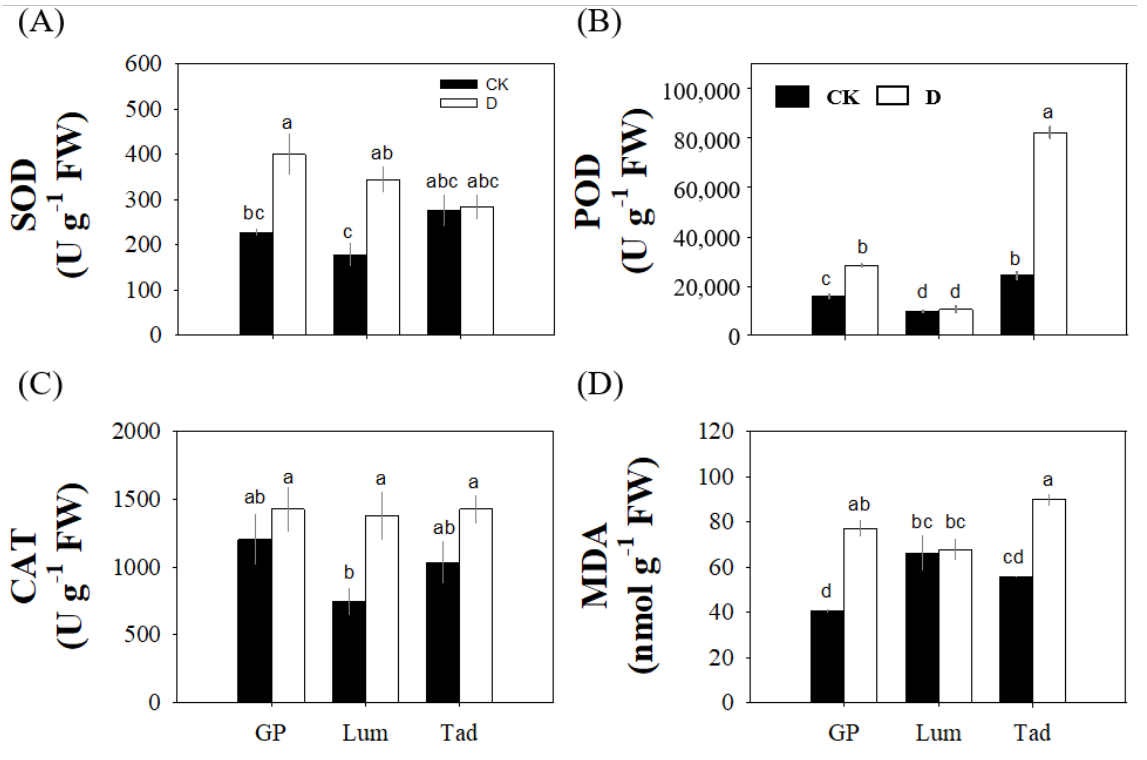
Figure 8. Antioxidant capacity assessment in GP, Lum, and Tad. Activities of SOD ( A ), POD ( B ), CAT ( C ), and contents of MDA ( D ) under control (CK, black bar) and drought (D, white bar) stress conditions. Data are presented as the means ± se of three biological replicates and different letters above the error bars indicate significant differences at p < 0.05.